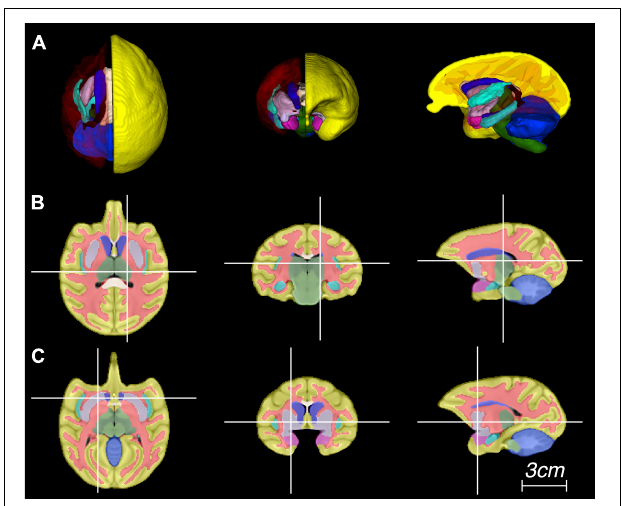
FIGURE 4 | Representative images of the atlas in panel (A) three-dimensional rendering, and (B,C) multiplanar views centered at the thalamus and putamen,